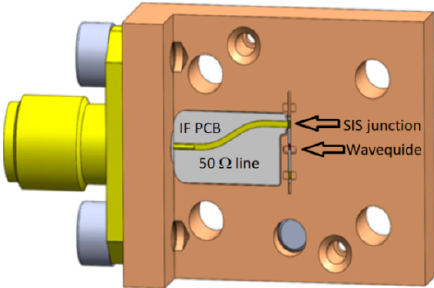
Figure 7. A 3D model of the back piece. A PCB plate, the SIS mixer element and waveguide are depicted.